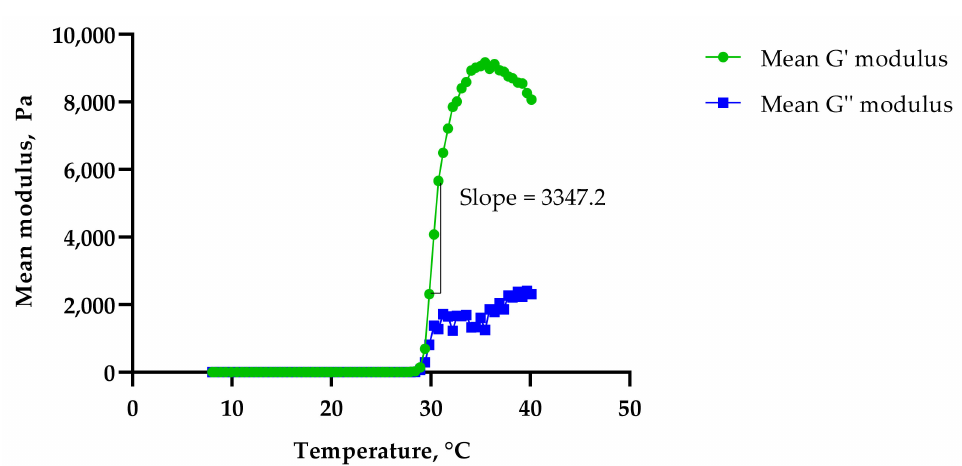
Figure 8. Sol–gel transition temperature for F3.